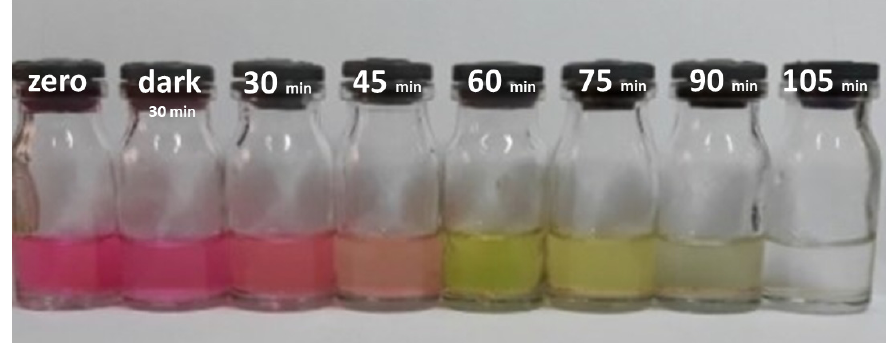
Fig. 11. Color change of the RhB solution under visible light irradiation and in the presence of N -TiO 2 /C. Measurement conditions: 40 mg photocatalyst, 40 mL RhB aqueous solution containing 10 ppm of RhB, and a light source of 40‐Watt white LED lamp